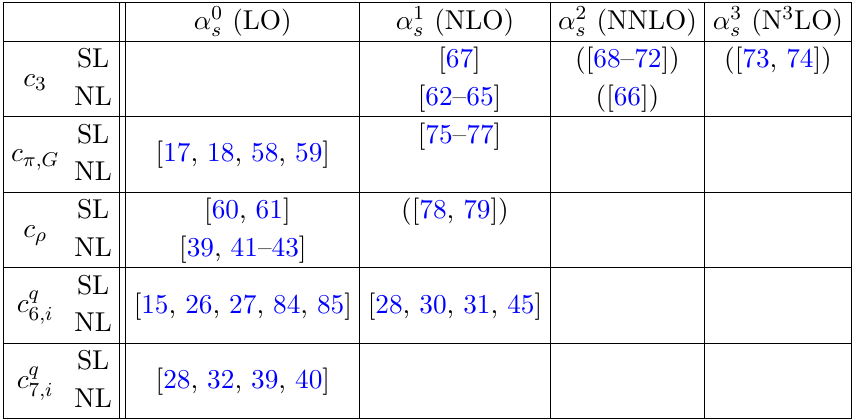
Table 4. Summary of main references for contributions to the heavy hadron decay rates, arranged by order in the 1 /m and α expansions, with the upper three rows referring to non-spectator c s contributions (ie two-quark matrix elements), and the lower two rows referring to spectator con- tributions (ie four-quark matrix elements). The notation in the leftmost column corresponds to eq. (2.15). If a contribution is not available, the cell is left empty (the exception is the leading Γ term, which in effect has been known since the 1950s). Contributions that have not been included in our computations, but may be useful for future studies, are indicated in brackets (). More details, and other key references, are also provided in the main text. Some exploratory work on higher-order non-spectator contributions in semileptonic channels is available in, for example, [34–37, 88], but since little is known about matrix elements at this order, we do not include such contributions in our